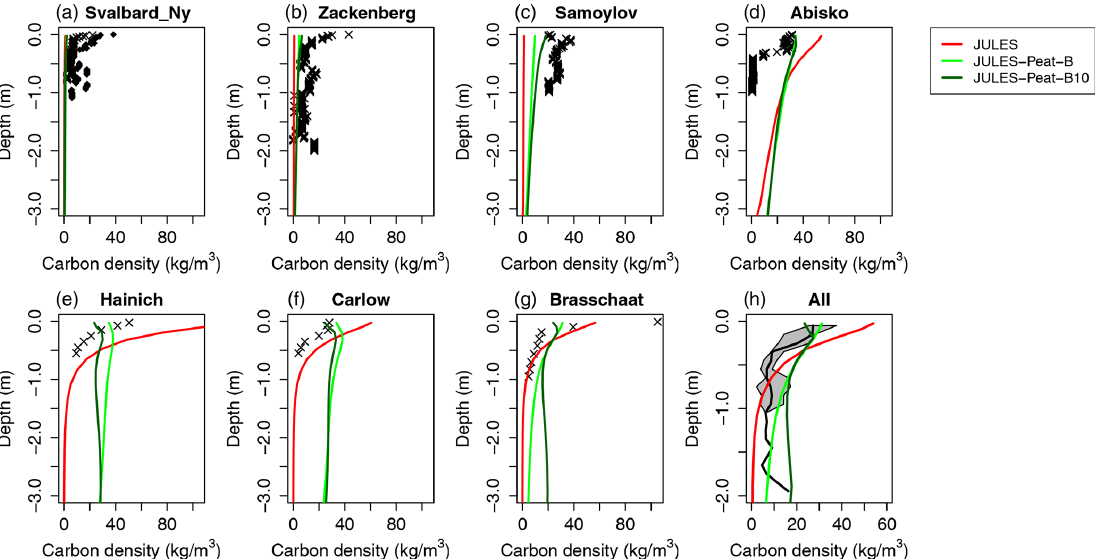
Figure 3. Evaluation at mineral sites. Observations are shown with black crosses or lines. The black line in (h) is the median of all sites, with the grey area indicating the interquartile range. Note that the axis ranges are different in (h) . The simulations JULES-Peat-B and JULES- Peat-B10 have different values of τ lit . For information about the sites refer to Table 1, and for details of the JULES simulations refer to Table 2. Table 3. RMSEs of JULES simulations against various observations. “Temp.” is short for temperate. The final two columns refer to the median of the site-specific observations shown in Figs. 3 and 4 respectively. The best-performing simulation for each column is highlighted in bold.